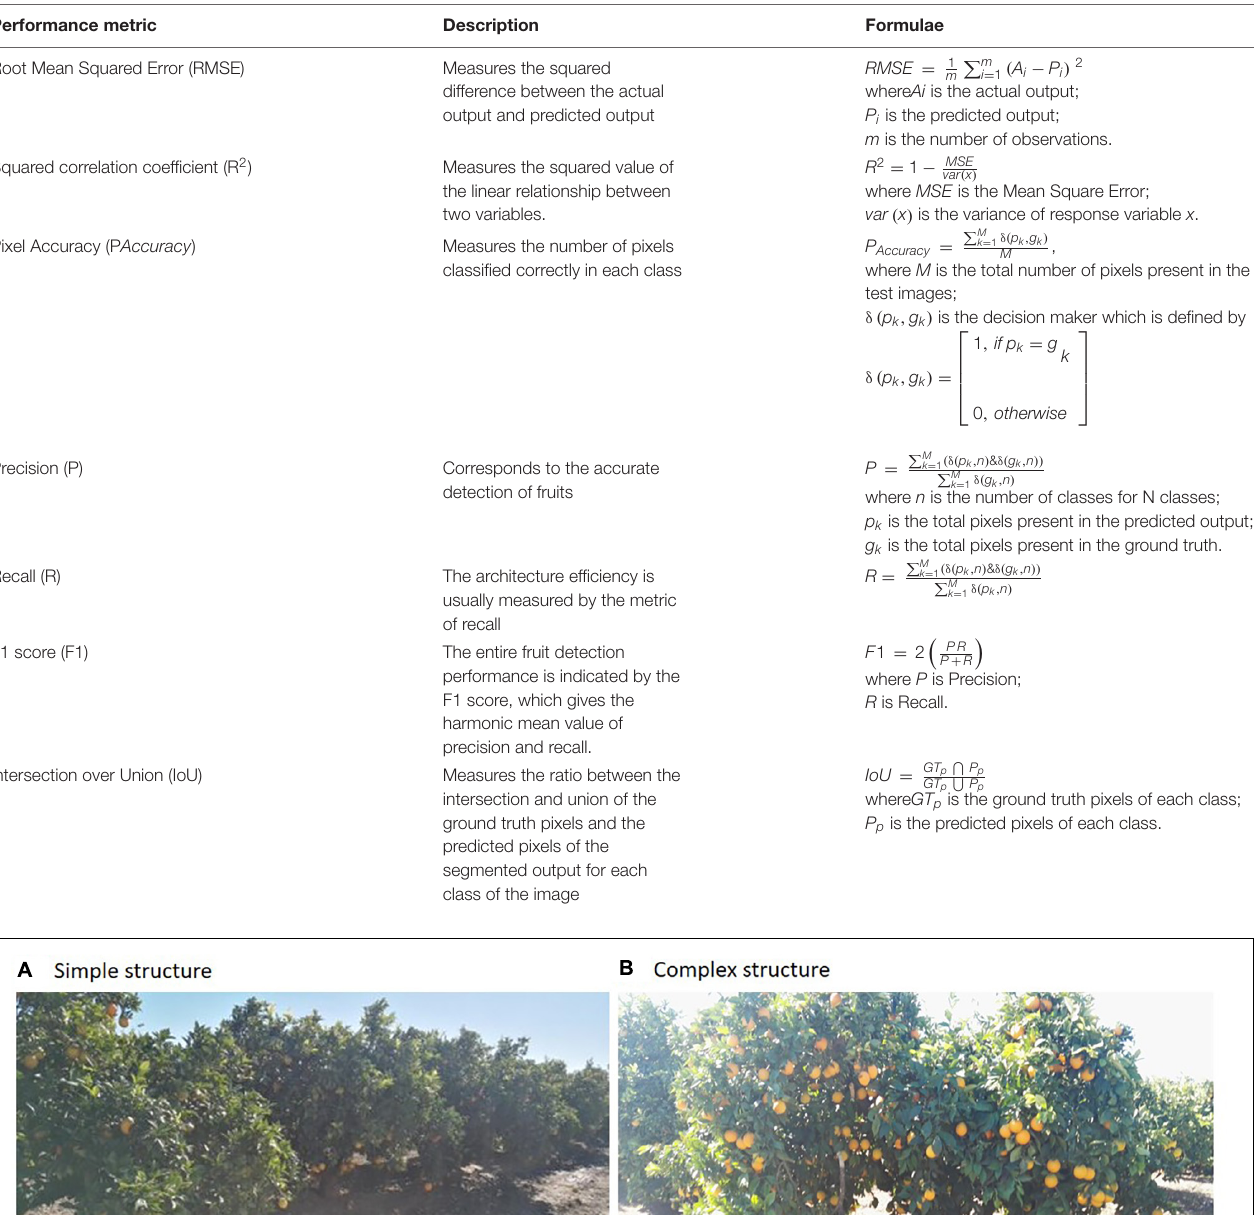
TABLE 5 | Performance metrics used for evaluating semantic segmentation architectures.